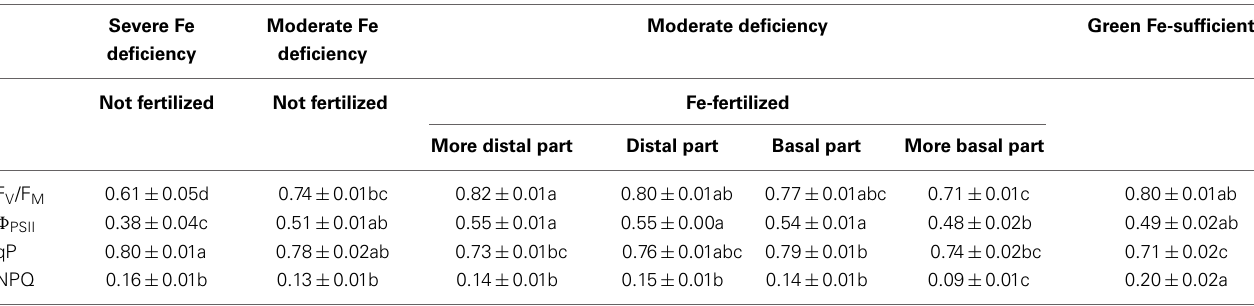
Table 5 | Chl fluorescence parameters (F V /F M , (cid:2) PSII , qP, and NPQ) in severely and moderately Fe-deficient, distal treated and basal untreated areas of fertilized leaves, and Fe-sufficient peach tree leaves. Severe Fe Moderate Fe Moderate deficiency Green